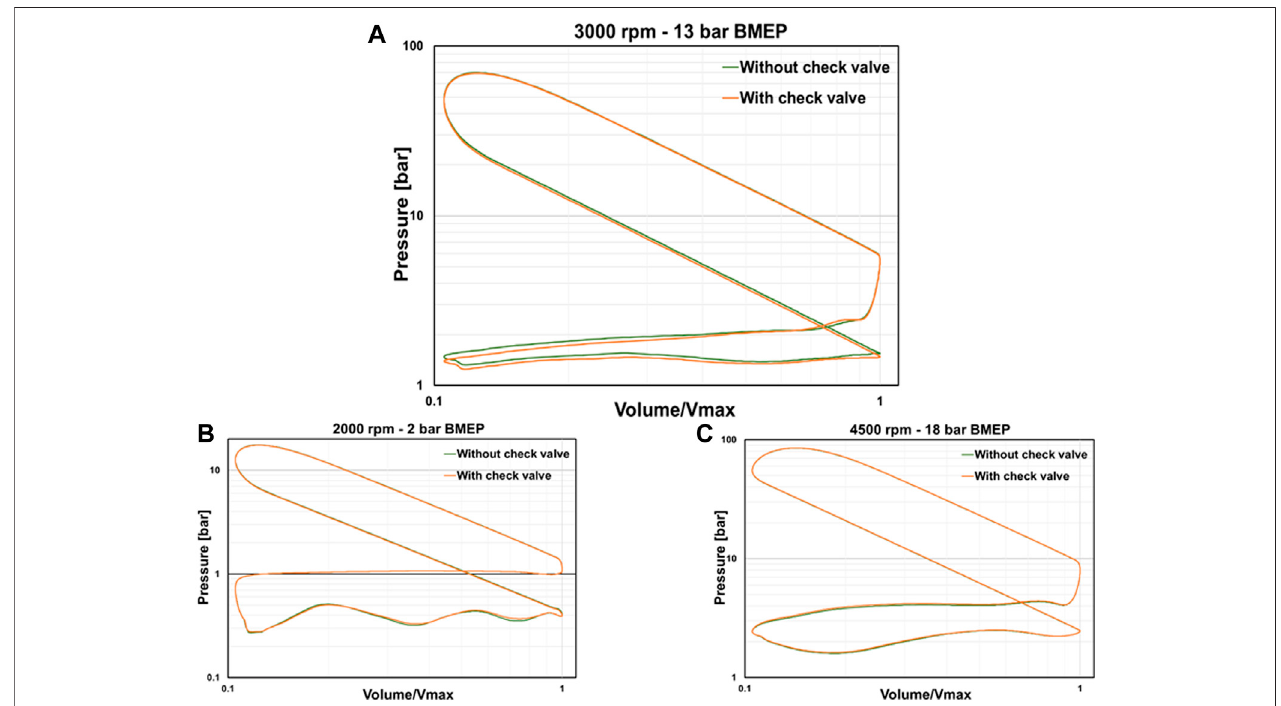
FIGURE 12 | Log P vs. Log V comparison with and without check valve at (A) 3,000 rpm, 13 bar BMEP; (B) 2,000 rpm, 2 bar BMEP and (C) 4,500 rpm, 18 bar BMEP.